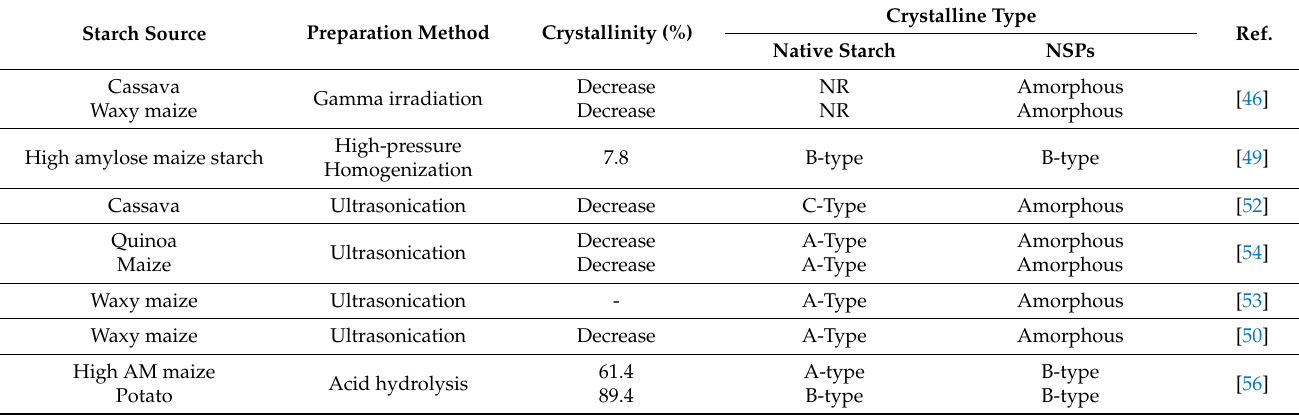
Table 3. Crystallinity of starch nanoparticles from various preparation